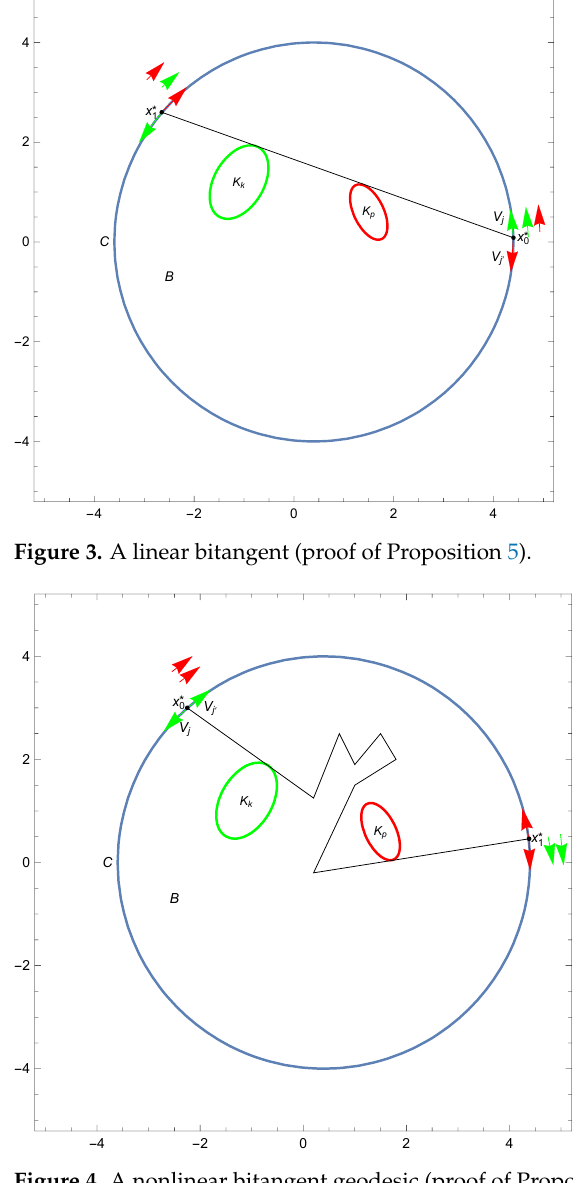
Figure 4. A nonlinear bitangent geodesic (proof of Proposition